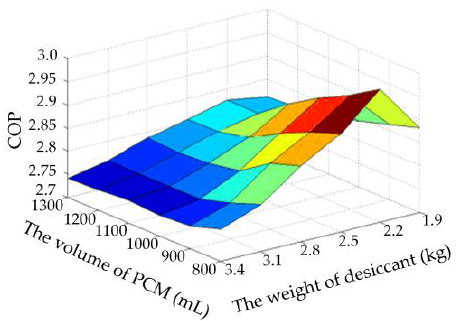
Figure 25. Effects of the amount of desiccant and phase change material (PCM) on the COP of FFASHP water heater system [52].